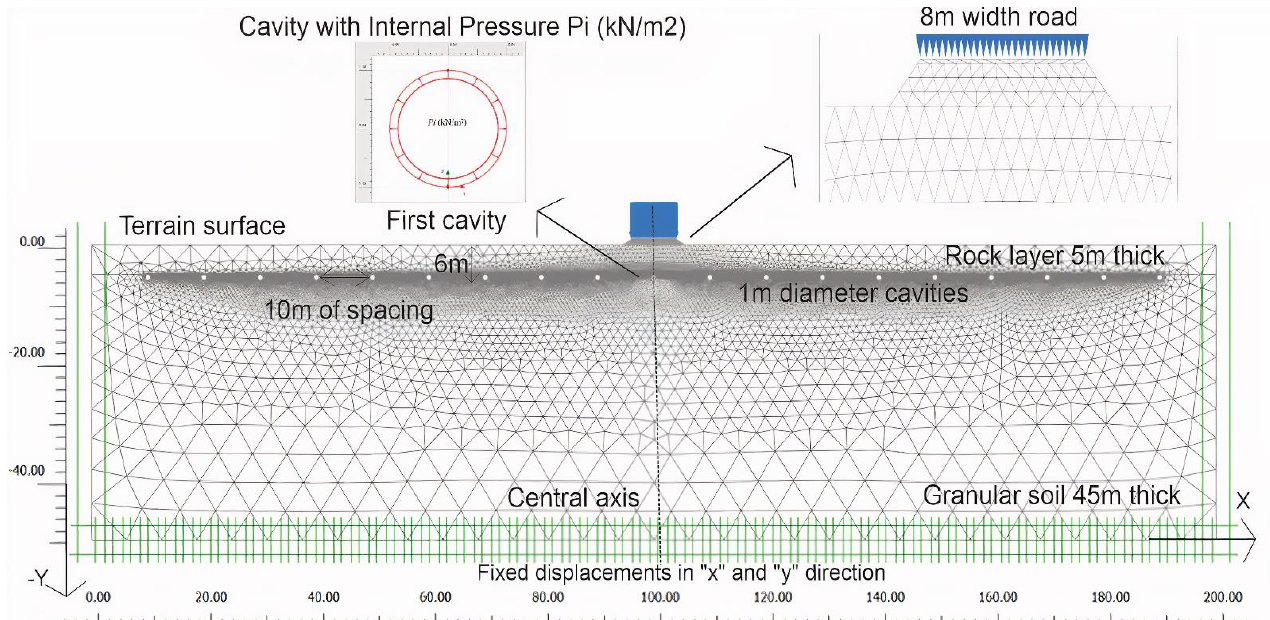
Figure 5. The numerical model with the mesh discretization using 32,779 triangle elements and 65,940 nodes.